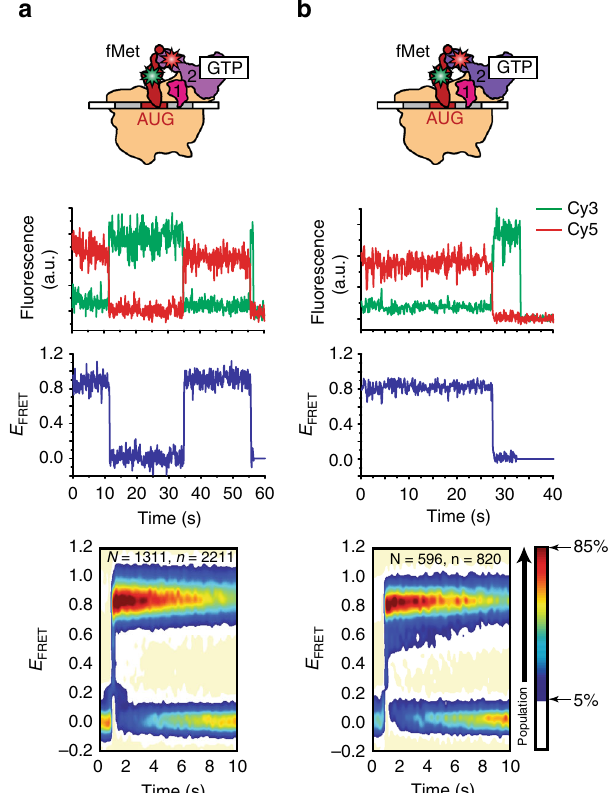
Fig. 1 Effect of GTP and fMet-tRNA fMet . smFRET measurements of IC mT , respectively. First row: cartoon illustrations depicting 30S IC wT -bound Second row: representative Cy3 (green) and Cy5 (red) emission intensities vs. time trajectories. Third row: corresponding E FRET vs. time trajectories. Fifth row: post-synchronized surface contour plots of the time evolution of population FRET. Surface contour plots were generated by superimposing hundreds of individual IF2-binding events. “ N ” indicates the total number of E “ n ” indicates the total FRET vs. time trajectories for each 30S IC and number of individual IF2-binding events. The surface contours were plotted from tan (lowest population plotted) to red (highest population plotted) as indicated in the population color